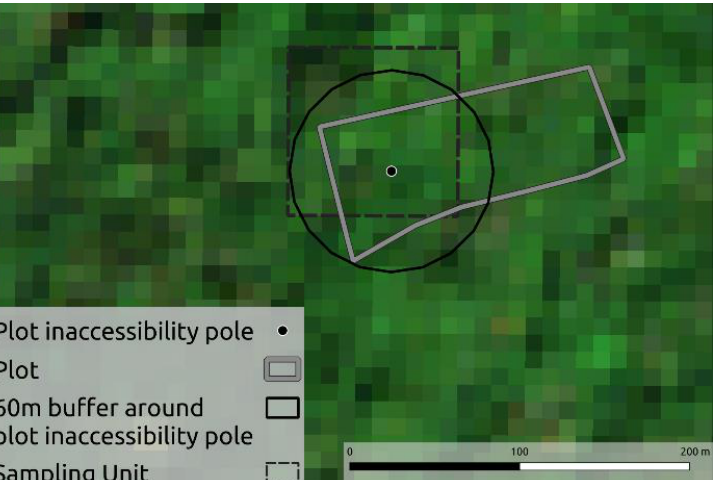
Figure 2. Illustration of the field plot LHC defined by its original contour (gray boundaries), the corresponding inaccessibility pole and 60 m radius circular buffer, and the 1 ha sampling unit defined in biodivMapR when mapping diversity indices over the whole image. The background corresponds to the RGB color composite of the original S2 image with 10 m spatial resolution.